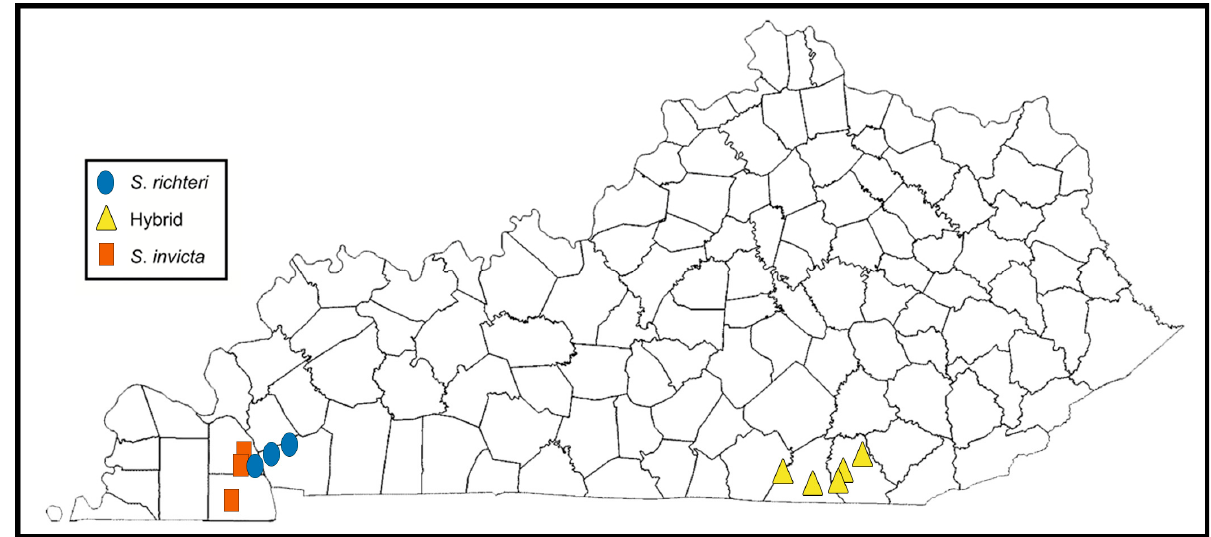
Figure 2. Map of Kentucky showing counties where imported fi re ants have been reported. Screening Center for determination and based on GC/MS, genetic assay, and morphology, the specimens were identi fi ed as S. invicta , which corroborated earlier identi fi cations of fi re ants from the same site. All mounds at the Kenlake sites were treated beginning in September 2017 and retreated in October 2017. The treatments appeared to be successful as no fi re ants were found on return visits to the site after the collections were made in